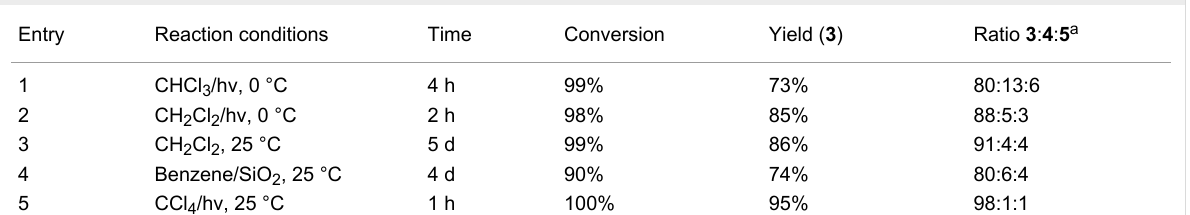
Table 1: Bromination of 9,10-dibromoanthracene ( 2 ) with molecular bromine (2.5 equiv). Entry